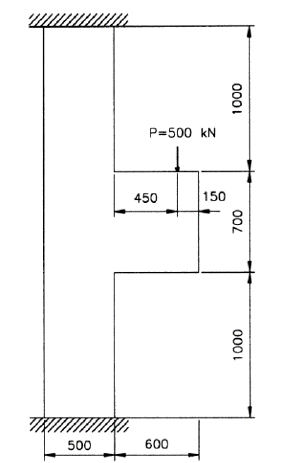
Figure 6. Rectangular corbel (dimensions in mm)